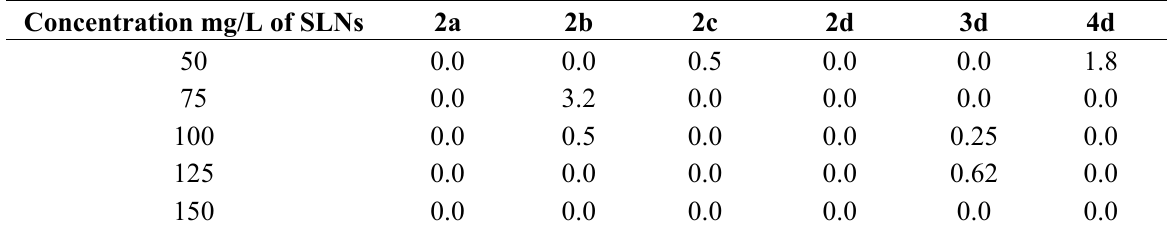
Table 3. Results of the haemolysis experiments (expressed as a percentage of total haemolysis caused by hypotonic stress) at calix-arene SLN concentrations varying from 50 to 150 mg/L, values are derived from the O.D. measured at 540 nm. Concentration mg/L of SLNs